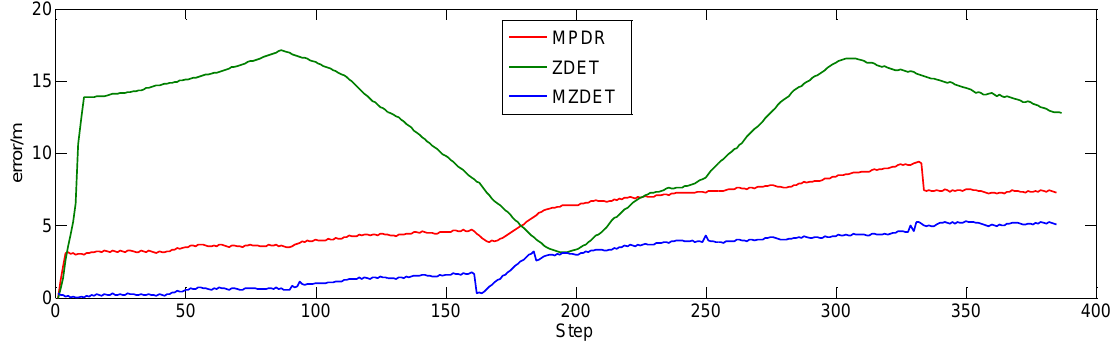
Figure 16. The error step series of the three schemes.